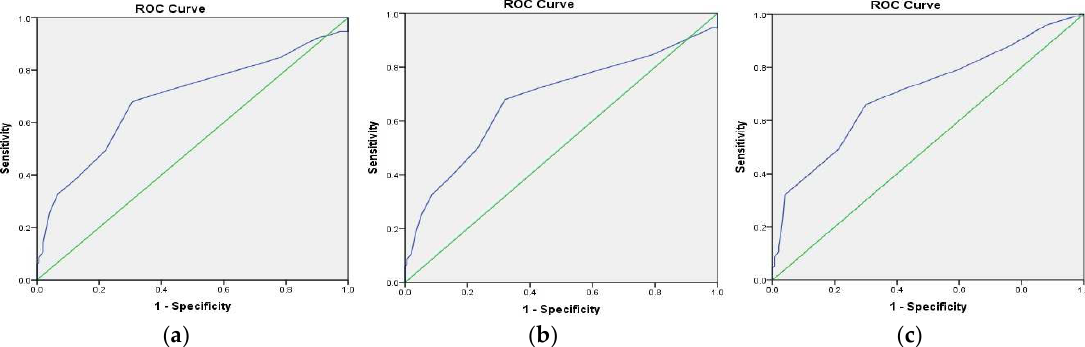
Figure 5. Receiver operating characteristics (ROC) curve showing the area under curve for the landslide susceptibility maps produced using various MFs in ANFIS based models and Frequency ratio model: ( a ) AUC = 68.8%; ( b ) AUC = 67.8%; ( c ) AUC = 70.7%.